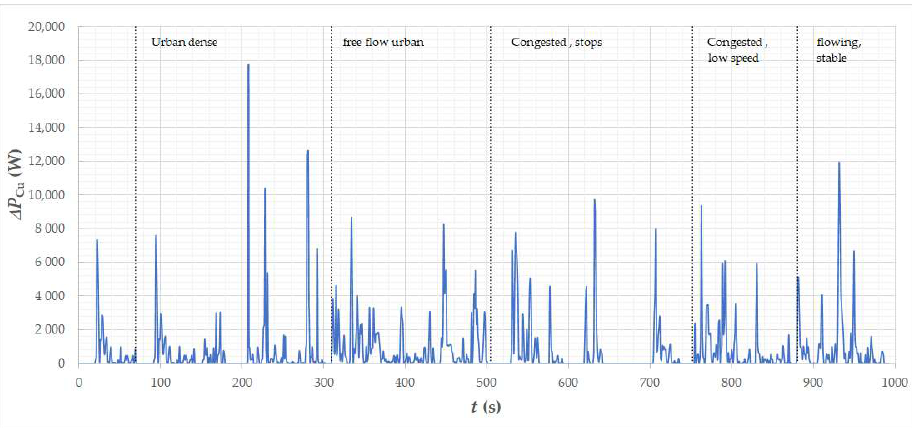
Figure 17. Calculated waveforms of loss in winding of the motor for the Artemis Urban cycle .